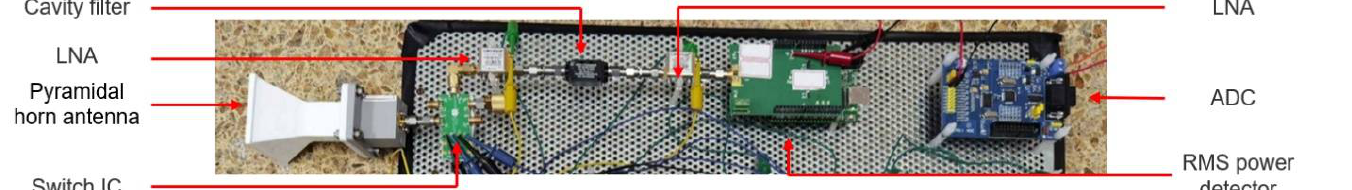
Figure 8. Full-power microwave temperature radiometer prototype.